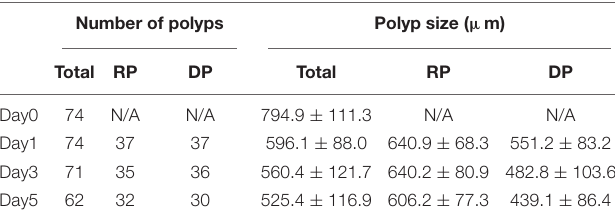
TABLE 3 | Numbers of differentially expressed genes in pairwise